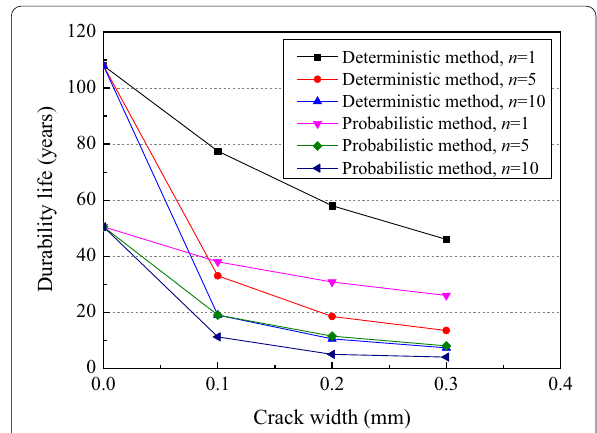
Fig. 7 Predicted durability life considering the crack effect.